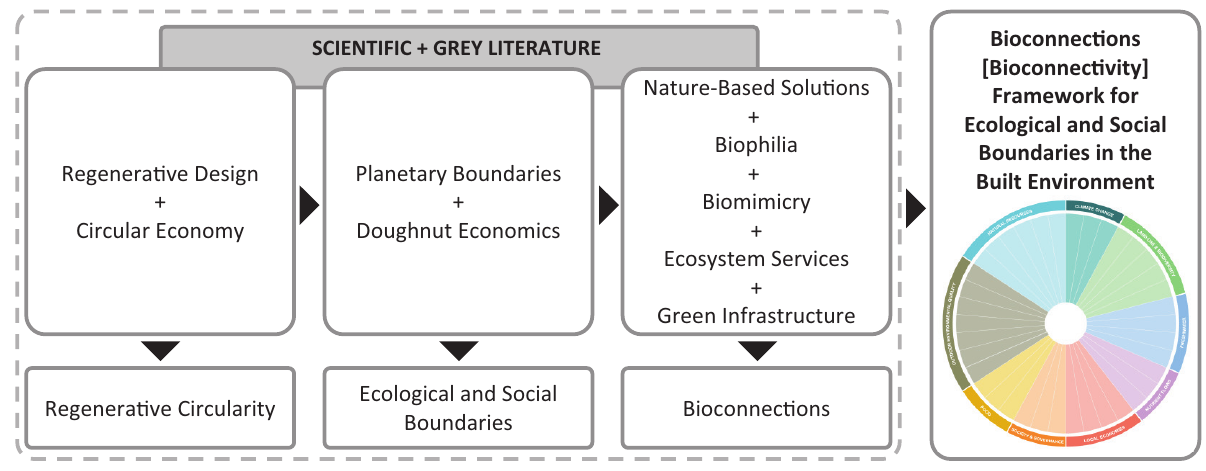
Figure 2. Methodological